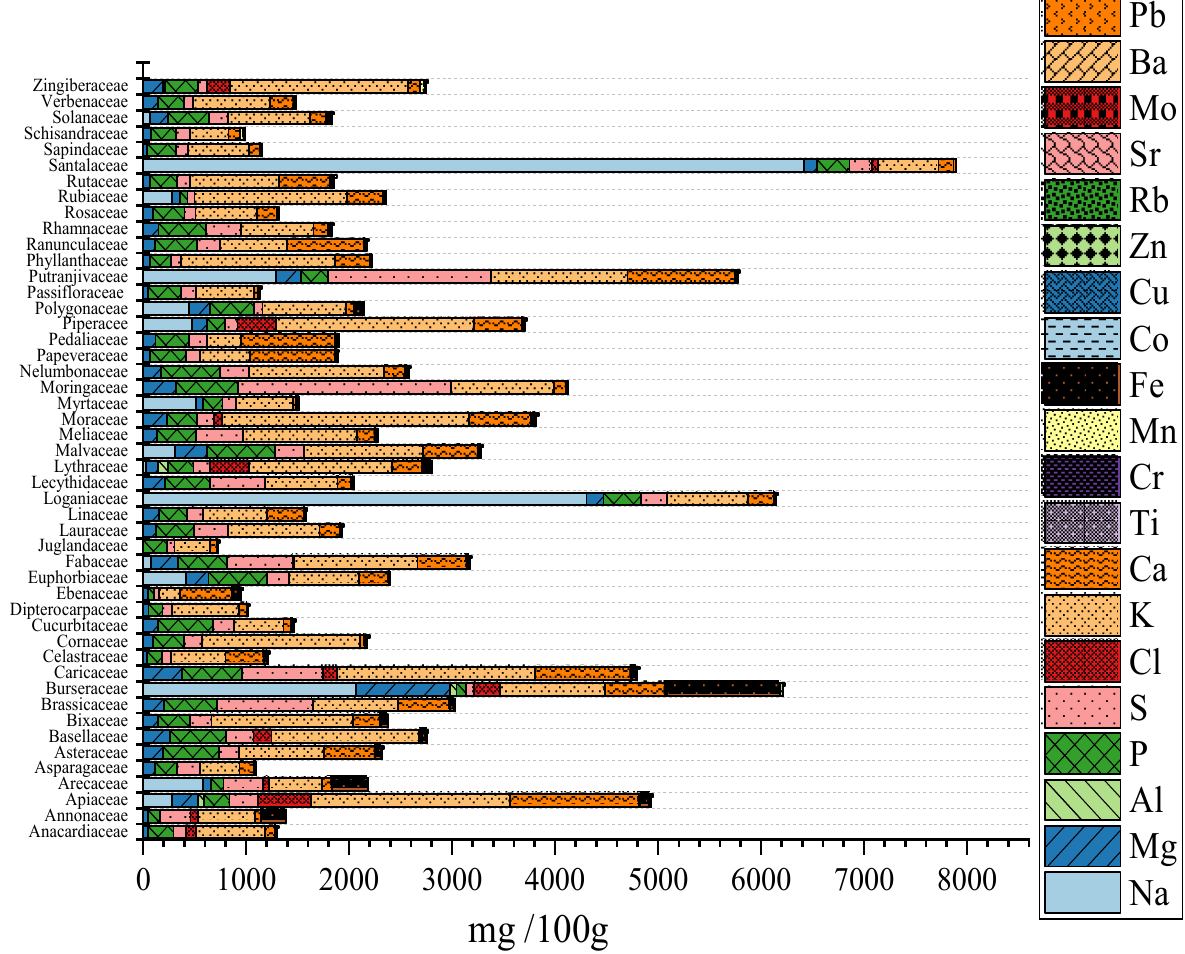
Figure 2. Mineral element content grouped by families. Magnesium is the main component of chlorophyll [53] and was identified in the seeds from 147 species, at concentrations between 34 and 910 mg/100 g, in line with other seeds [29,40]. High Mg contents (>395 mg/100 g) were detected in the seeds from Abelmoschus esculentus , Acacia nilotica , Cassia fistula , Commiphora wightii , Corchorus olitorius , Parkia javanica , Pterocarpus marsupium and Urena lobata , which are similar to those reported for barley [55] and millet seeds [56]. The highest Mg accumulation was noticed in seeds belonging to the Amaryllidaceae, Burseraceae, Caricaceae and Moringaceae families. Calcium is also an important mineral for human nutrition that was accumulated at concentrations in the 3.0–1786 mg/100 g range in the seeds from 155 species (Table S1). These are values quite similar to those for weeds such as Panicum sumatrense , Setaria italica , Cassia tora , Heliotropium indicum , Rorippa palustris and Ludwigia parviflora [14N]. Abundant Ca accumulation (919–1253 mg/100 g) was observed in the seeds from four families: Apiaceae, Caricaceae, Pedaliaceae and Putranjivaceae (Figure 2). Strontium content in 125 cultivars varied from 0.1 to 27.4 mg/100 g. These are higher levels than those described for weeds, pulses and beans from India [29,40]. High Sr content (from 21 to 27 mg/100 g) was accumulated in two Apiaceae family species: Daucus carota spp. Sativus and Foeniculum vulgare . Rubidium concentration in the seeds under study ranged from 0.2 to 13.4 mg/100 g; such high Rb accumulation was registered in Lepidium sativum seeds. These levels are similar to those found in other seeds [40] and within the normal range in foods